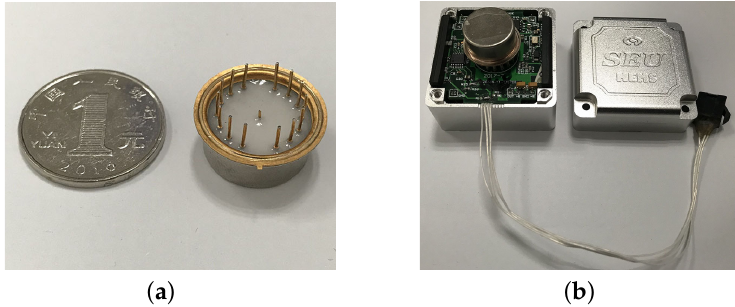
Figure 17. ( a ) The vacuum packaged gyroscope. ( b ) The gyroscope with the circuit.